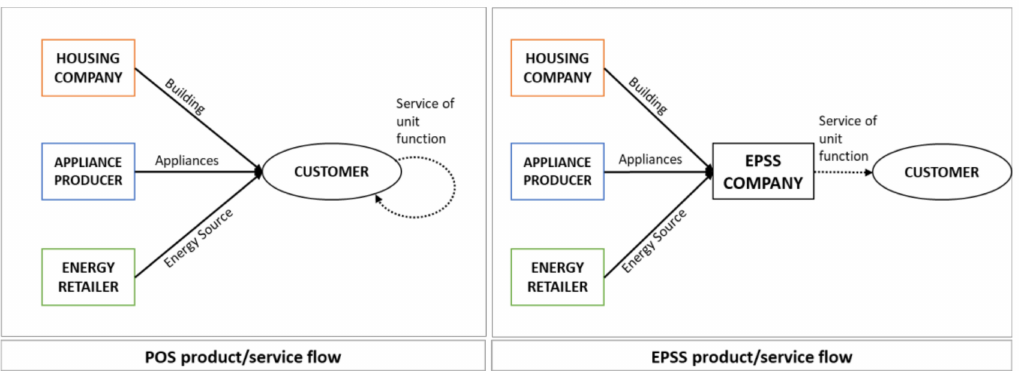
Figure 1. Energy, product and service flow in product oriented systems (POS) and energy product service systems